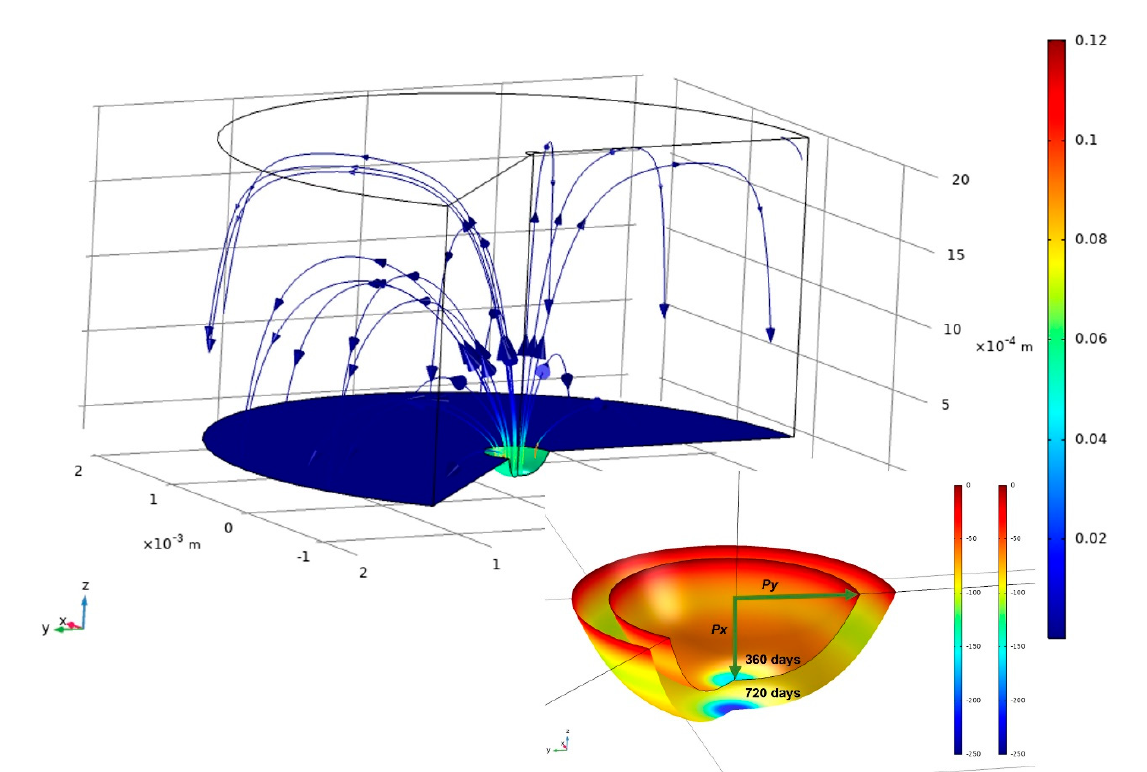
Figure 6. Above, simulation findings: pit growth and current lines at the electrodes and through the concrete (2 mm cathode radius, time = 360 d); below, variation in pit from 360 d to 720 d.